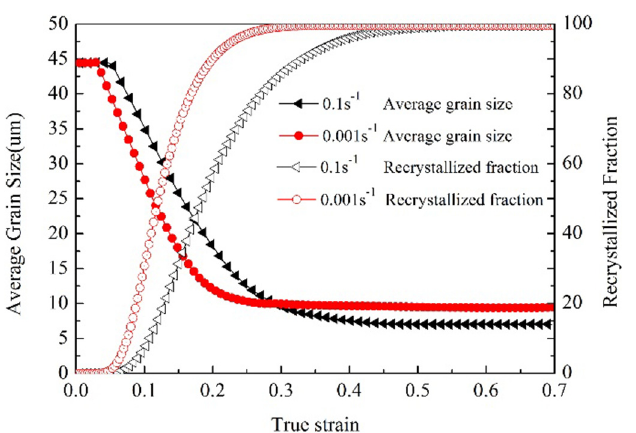
Fig. 7. The relationship between average grain size, strain rate, and recrystallization fraction ( T =400 ° C, _ e ¼ 0 : 1s (cid:1) 1